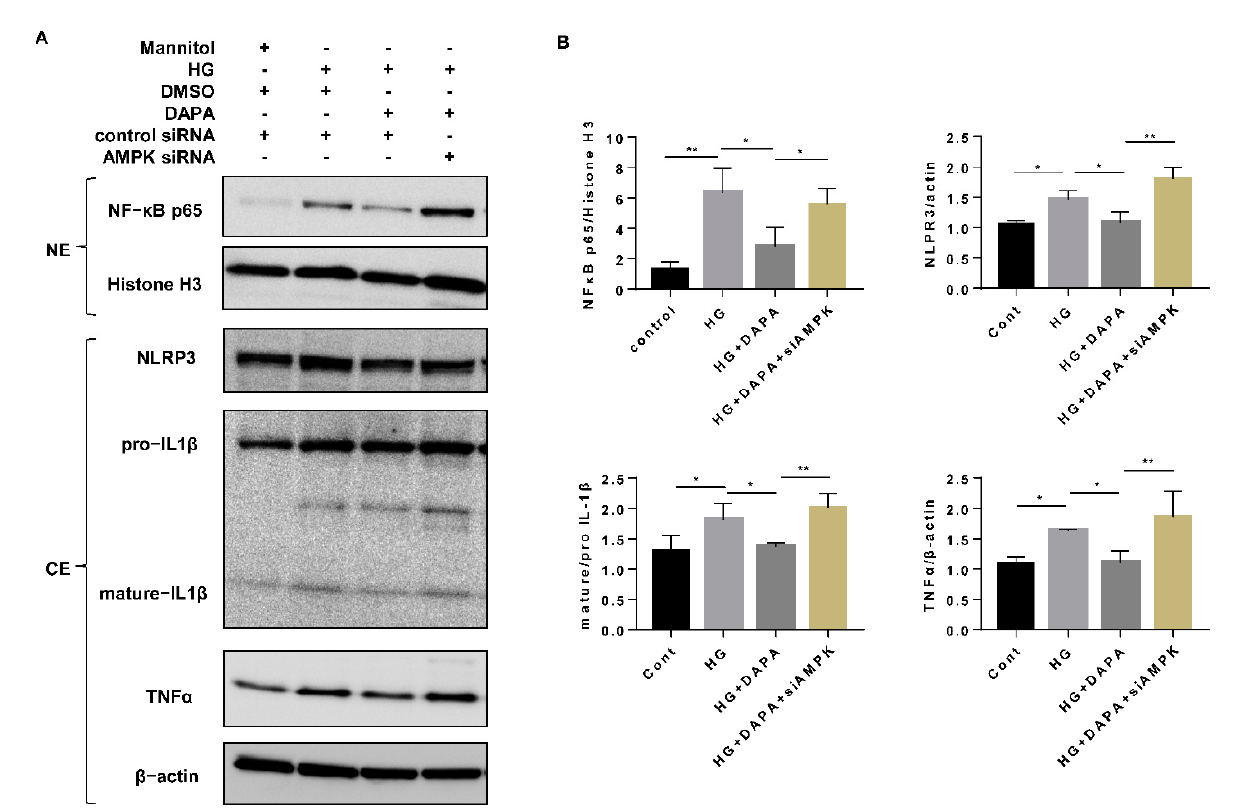
Figure 7. Dapagliflozin suppressed HG-induced nuclear NF- κ B p65 by activating AMPK. ( A ) HK-2 cells were transfected with AMPK siRNA (200 nM) or control siRNA for 6 h and then incubated with Cont, HG (30 mM), or HG (30 mM) with dapagliflozin (20 µ M) for 48 h. The levels of NF- κ B p65 in nucleoprotein extracts and NLRP3, IL-1 β , and TNF α in cytoplasmic protein extracts were assessed by western blotting. ( B ) Densitometric evaluation of ( A ) (n = 3). All data represent means ± standard deviation (SD). * p < 0.05 vs. the indicated group, ** p < 0.01 vs. the indicated group (n = 3). Cont, control; HG, high glucose; siCON, control siRNA; siAMPK, AMPK siRNA; NE, nucleoprotein extracts; CE, and cytoplasmic protein extracts.